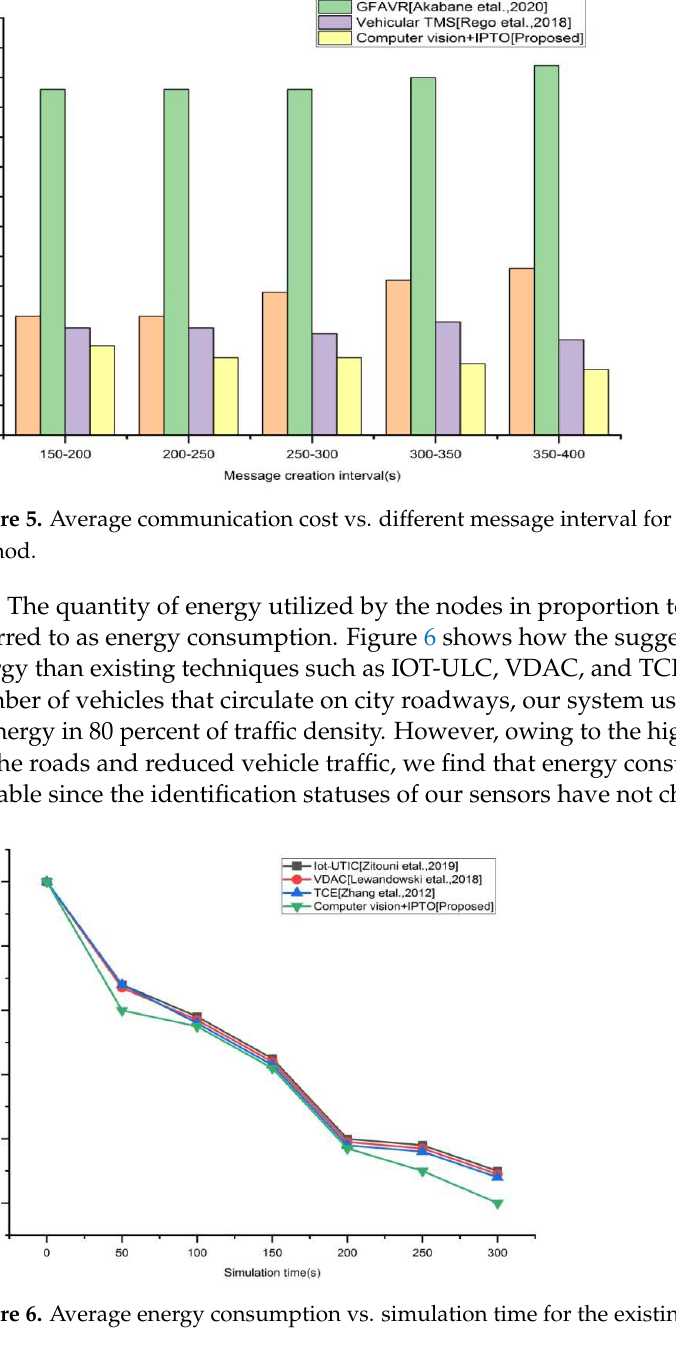
Figure 6. Average energy consumption vs. simulation time for the existing and proposed method.